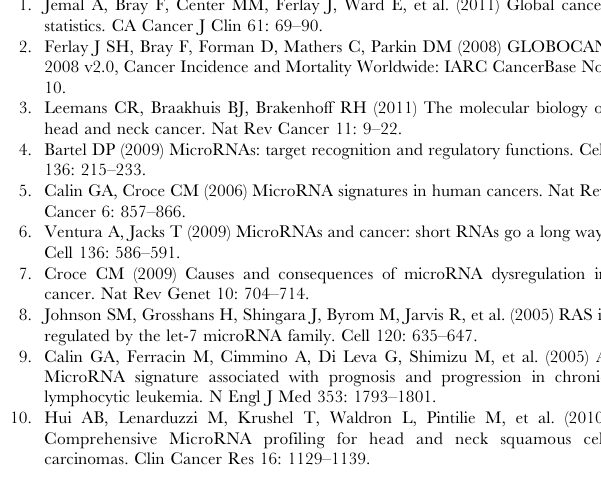
Figure S1 miR-193b over expression in HNSCC induced cell proliferation in UTSCC 42a and UTSCC 8 cells. (A) qRT-PCR analysis for miR-193b was conducted on 51 HNSCC primary tissue samples showing high expression in 43 relapsed vs. low expression for 8 non- relapsed tumors, relative to the expression of four normal larynx tissues. (B) qRT-PCR of miR- 193b expression in HNSCC cell lines 24–72 hours after transfection with LNA-193b (40 nM) or LNA-scramble (40 nM). (C) Cell viability was assessed in UTSCC 42a and 8 cells by the MTS assay 24, 48 and 72 hours post transfection with LNA-193b (40 nM) or LNA-scramble (40 nM). (D) Clonogenic survival of UTSCC 42a and 8 cells was measured 10 to 12 days after transfection with LNA-193b (40 nM) or LNA-scramble (40 nM). (E) Cell cycle analysis was performed on FaDu cells using flow cytometry 72 hours post transfection with LNA-193b (40 nM) or LNA-scramble (40 nM). **P , 0.005, ***P , 0.0005, P= ns (not significant).